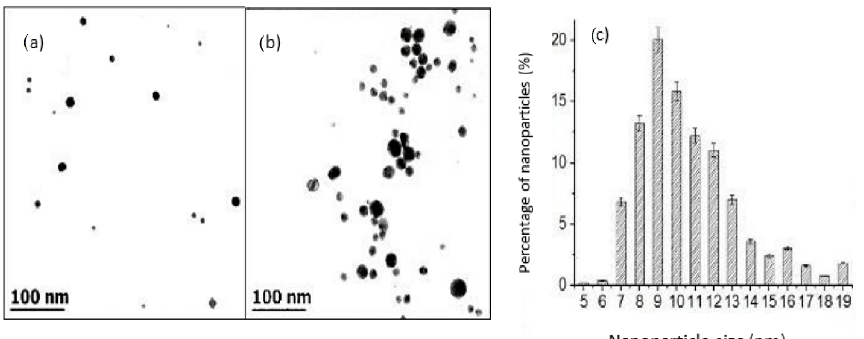
Figure 2. UV-vis spectrum of the liquid samples of gold nanoparticles synthesized with different concentrations.